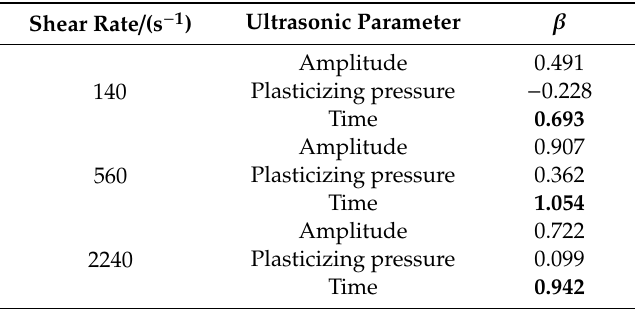
Table 8. MLRA results for Mode 1.